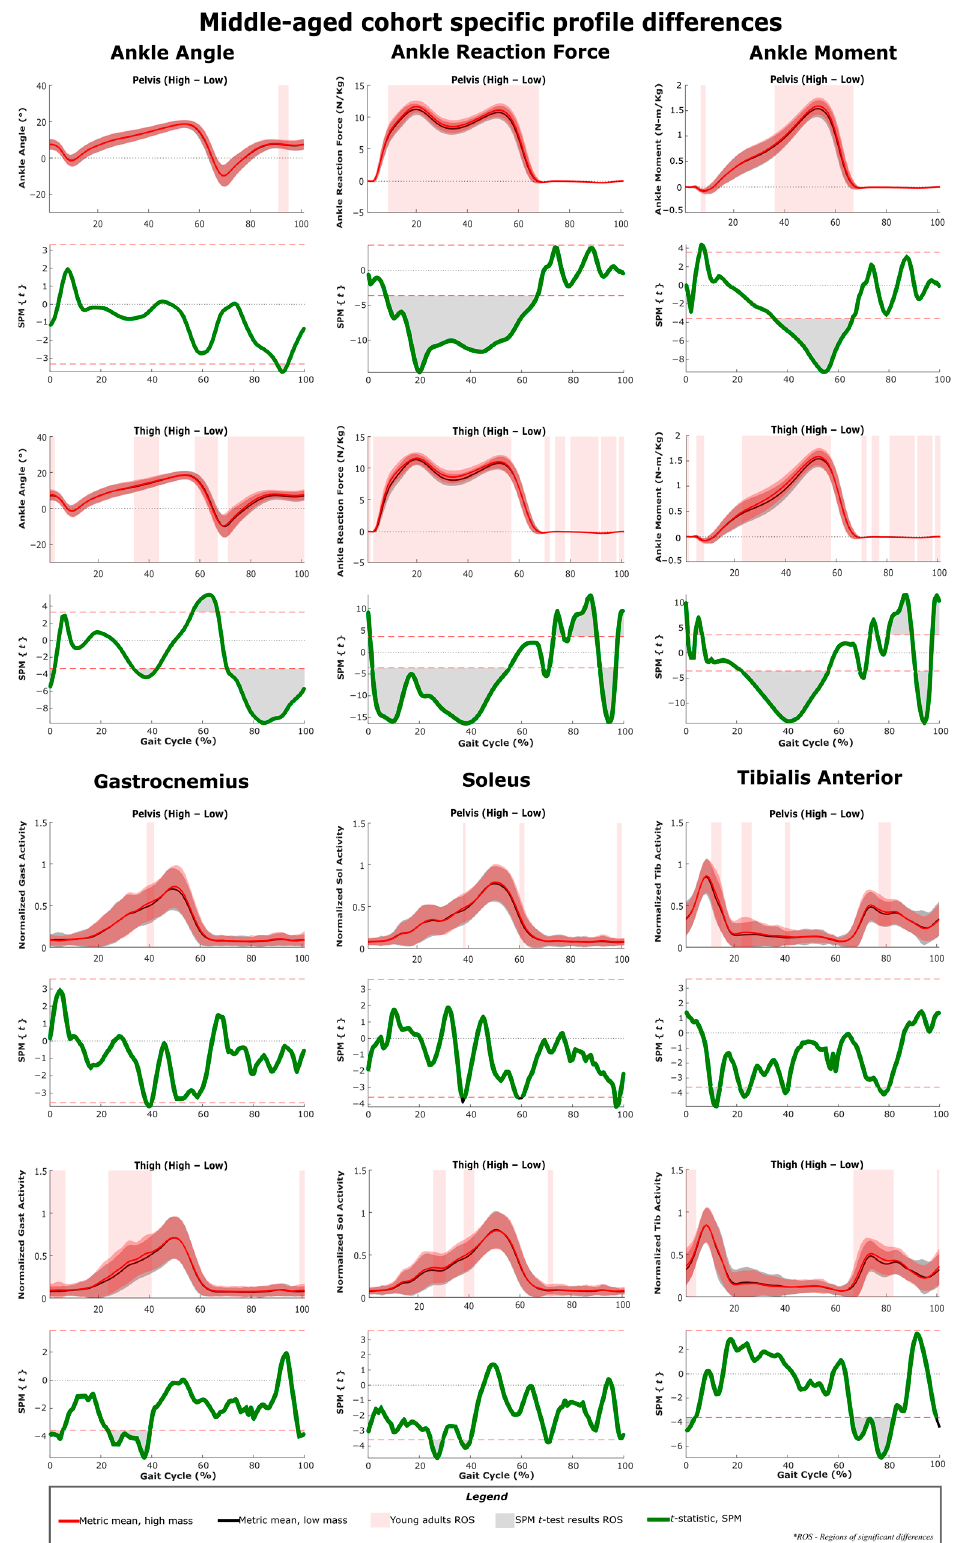
Figure 6. SPM t -test results and profile plots of the metrics, comparing low mass to high mass in the pelvis and thigh segments for participants in the middle-aged cohort. Joint parameters are primarily related to the ankle joint. The t -statistic is qualitatively identical to the effect size and can be used as an indicator of practical significance.